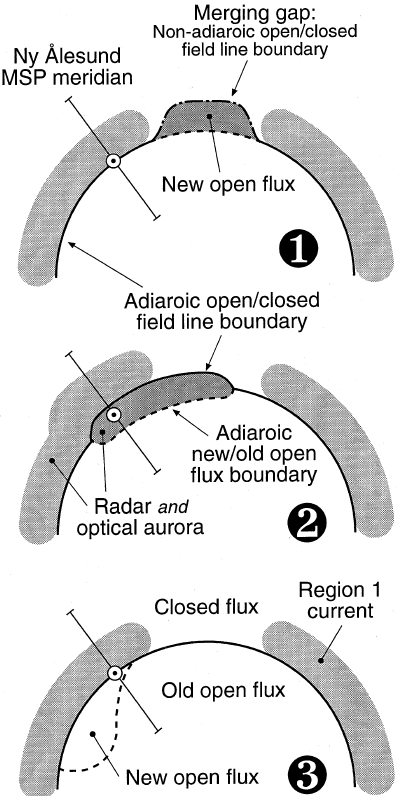
Fig. 8. A schematic diagram indicating three stages in the assimila- tion of a region of newly-opened flux with the old open flux of the polar cap (inside semi-circle) for B < 0 nT. Local noon is at the top y of the diagram and the approximate location of the MSP meridian is indicated in the post-noon sector. The solid line is the adiaroic open/ closed field line boundary. Dashed lines indicate the boundary between new and old open flux. The light grey regions in the pre- and post-noon sectors on closed field lines indicate the region 1 current location. (1) FTE footprint appended to front of polar cap at pre- noon reconnection site. The dot-dashed line represents the merging gap along which reconnection is on-going. This region subsequently drifts eastwards. (2) Region of newly-opened flux drifts into radar field-of-view and an equatorward step of the equatorward boundary of the aurora is observed. (3) Newly-opened flux assimilated with polar cap, OCFLB returned to quasi-equilibrium, drift velocity